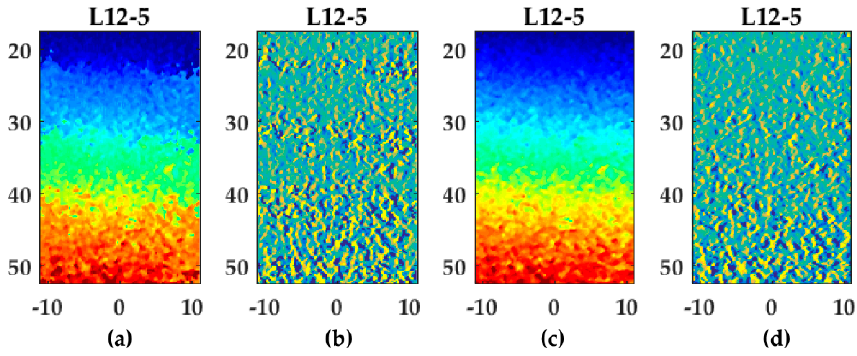
Figure 10. Lateral displacement and strain fields using Lu’s-fk for the L12-5 transducer: ( a , c ) displacement field using one ( a ) or two ( c ) lines per pitch. Please refer to Figure 6o for the color bar; ( b , d ) strain field using one ( b ) or two ( d ) lines per pitch. Please refer to Figure 6j and Figure 6t for the corresponding color bars.